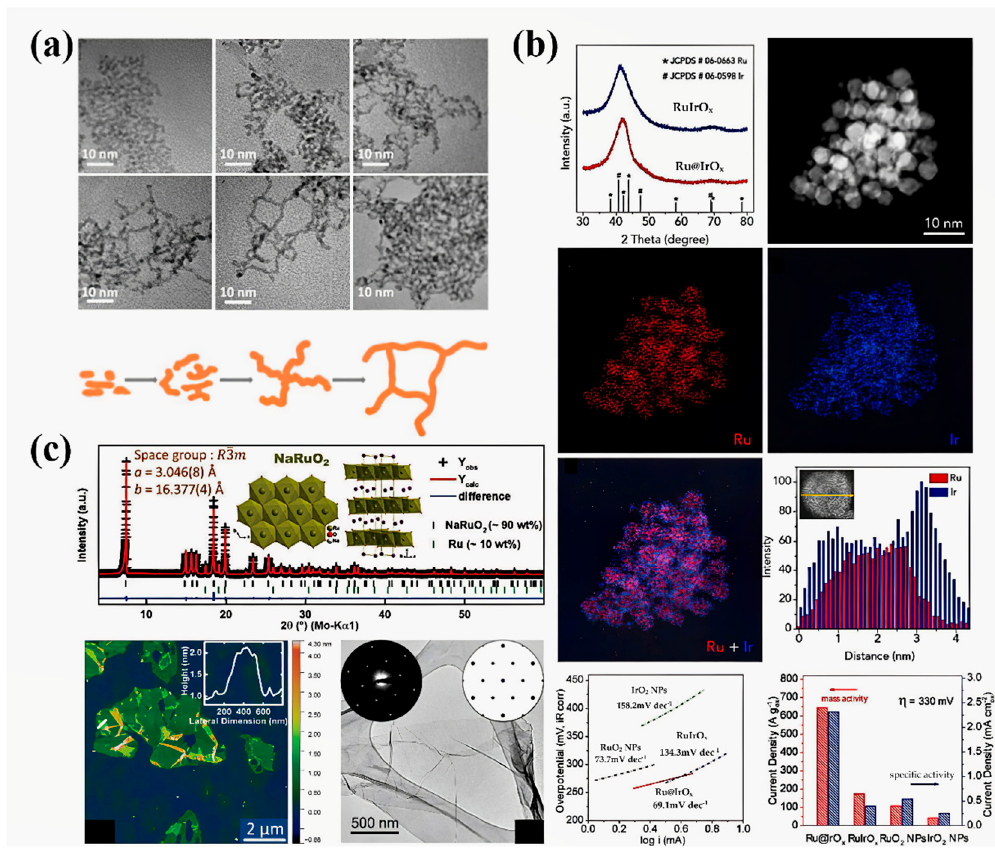
Figure 6. ( a ) TEM images and a schematic illustration of Ir nanowire intermediates obtained at different reaction times from 5 min to 20 h [62]. ( b ) Fine-structure characterization of a Ru@IrO x catalyst and investigation of its OER electrocatalytic activity [99]. ( c ) Fine-structure characterizations of ultra-thin NaRuO 2 nanosheets including the crystal structure, an atomic force microscopy (AFM) image, a TEM image, and selected area electron diffraction (SAED) patterns [100].